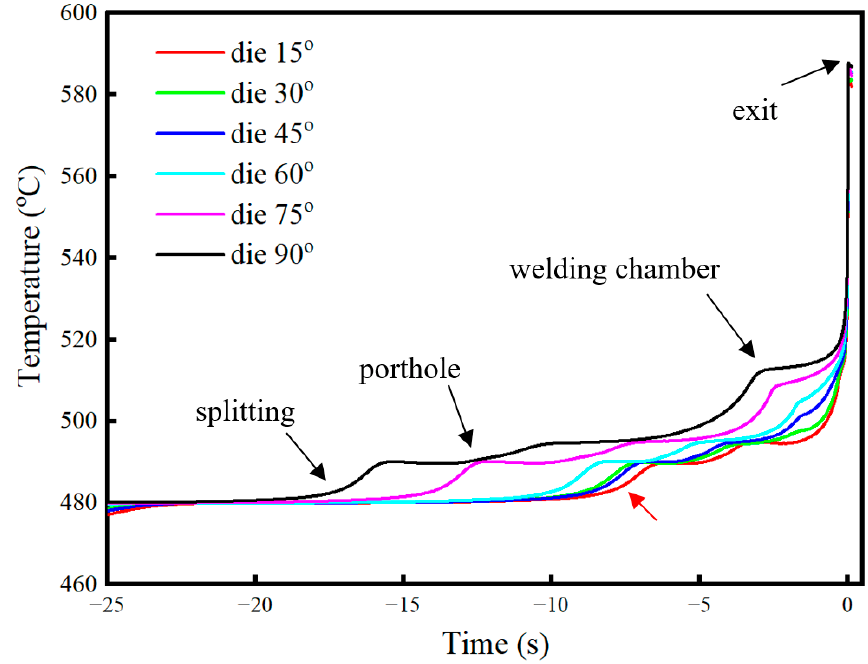
Figure 15. Model-predicted thermal history at the weld seam (mid-thickness) showing the effect of lower bridge angle.